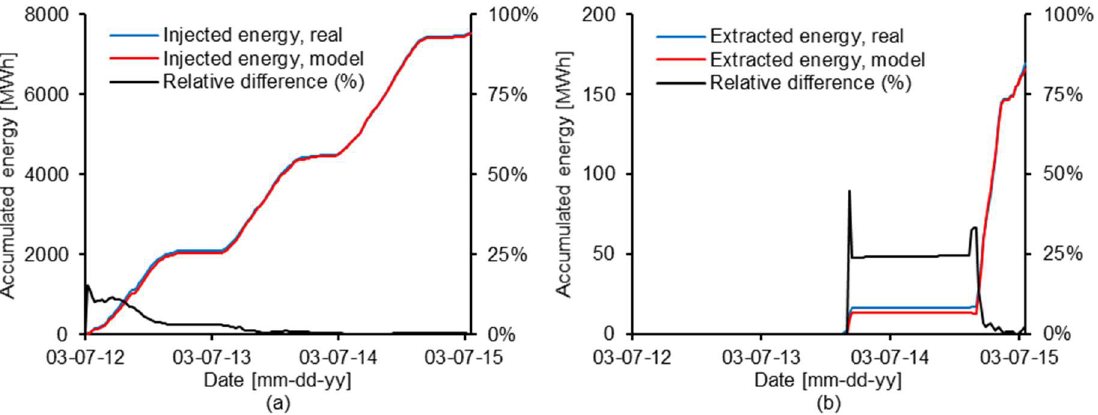
Figure 8. Injected ( a ) and extracted ( b ) energy, calculated versus measured. The relative difference between measured and calculated data is associated with right y-axis.